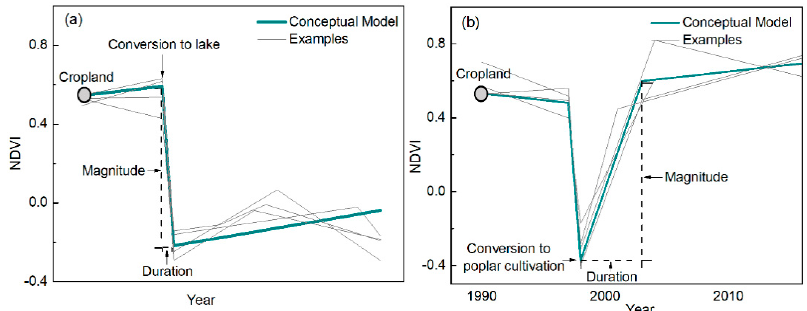
Figure 3. Conceptual models and several examples for cropland conversion in the CFTL: (a) Normalized Difference Vegetation Index (NDVI) trajectory of conversion to lake; (b) NDVI trajectory Di ff erence Vegetation Index (NDVI) trajectory of conversion to lake; ( b ) NDVI trajectory of conversion of conversion to poplar cultivation. to poplar